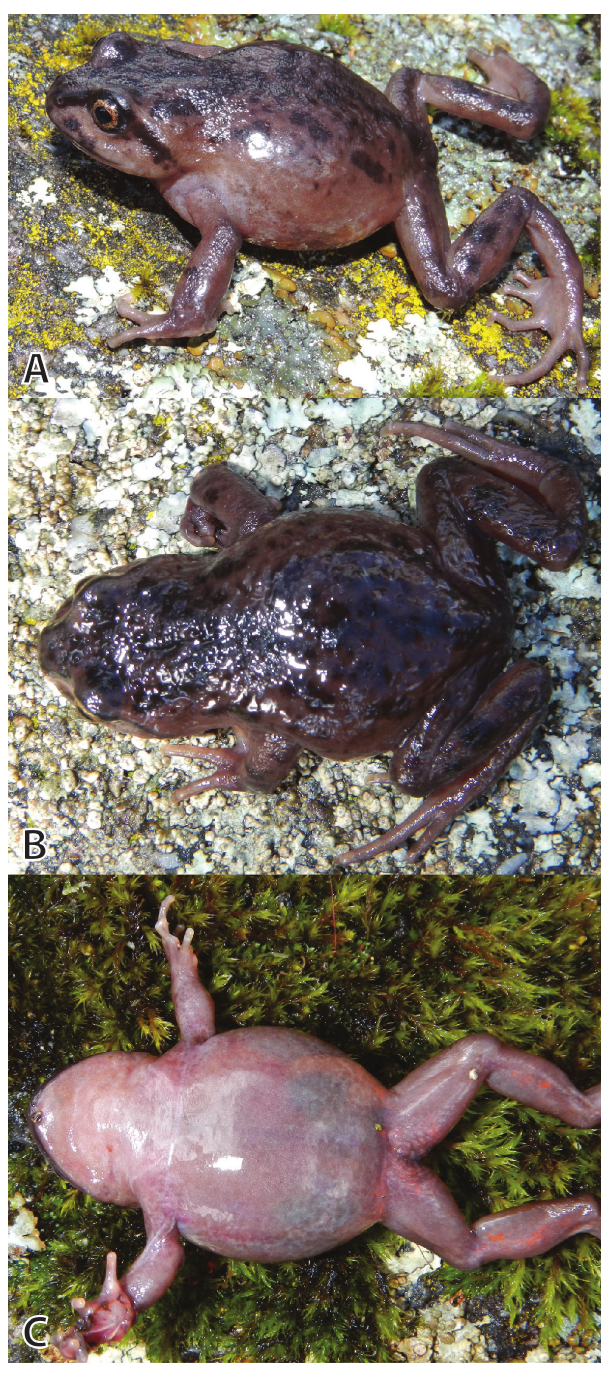
Figure 8. Female paratype of Phrynopus inti sp. n. (MUSM 31968, SVL 40.4 mm) in dorsolateral ( A ), dorsal ( B ), and ventral views ( C ). Photos by E. Lehr and J. Moravec